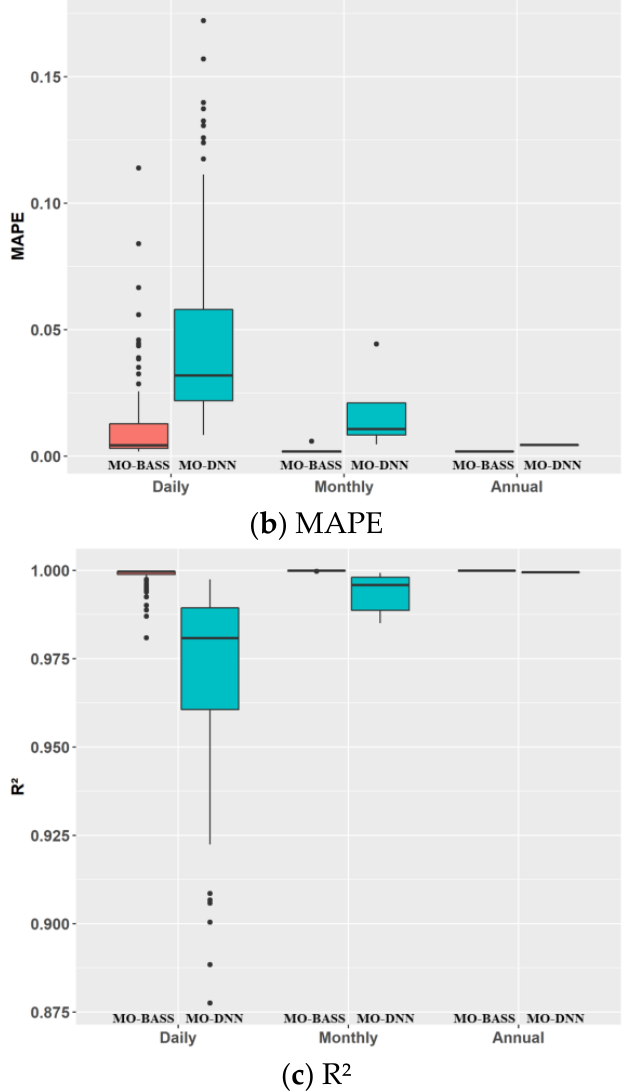
Figure 18. Prediction performance of two machine learning models for multi-time scales heating energy.